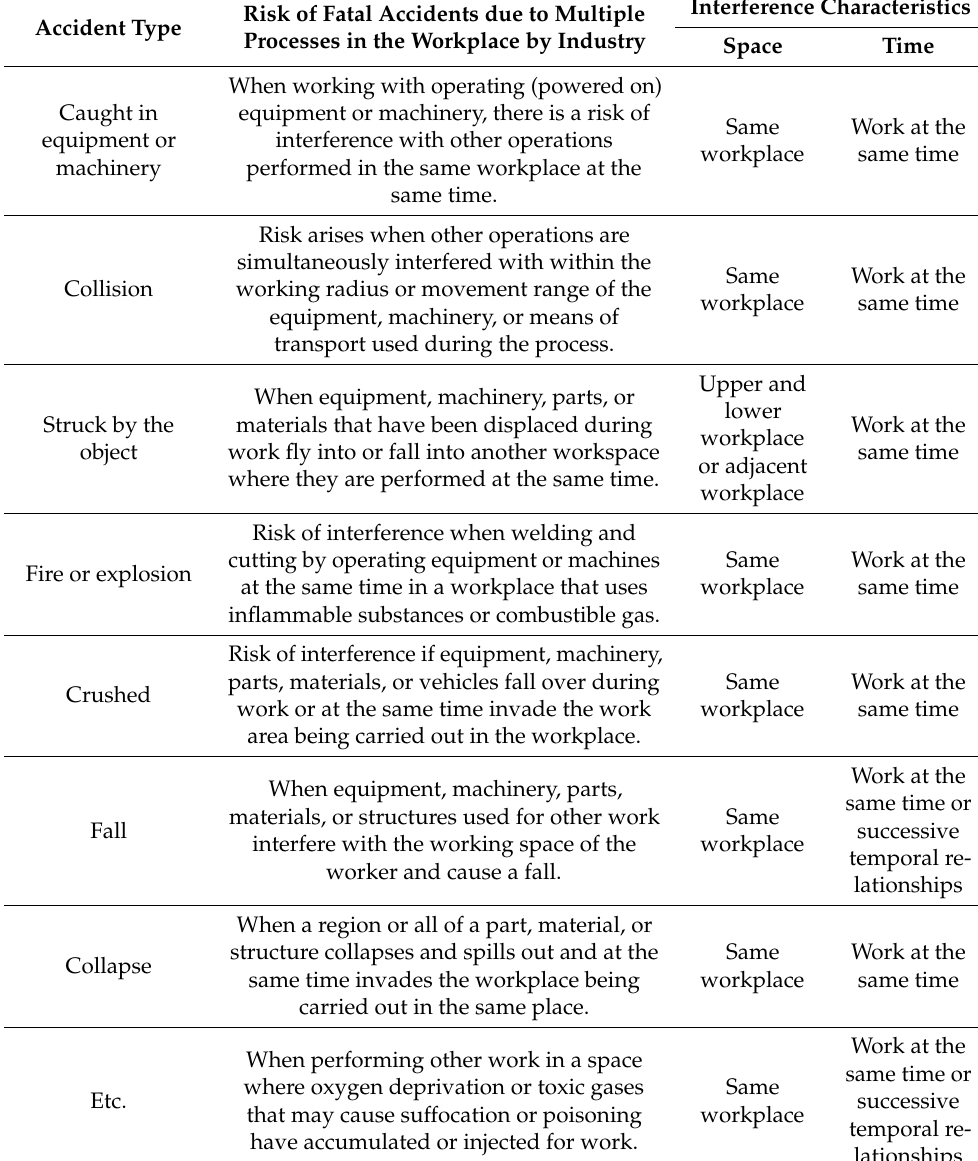
Table 3. Risks and characteristics of multiple processes in the workplace by accident types